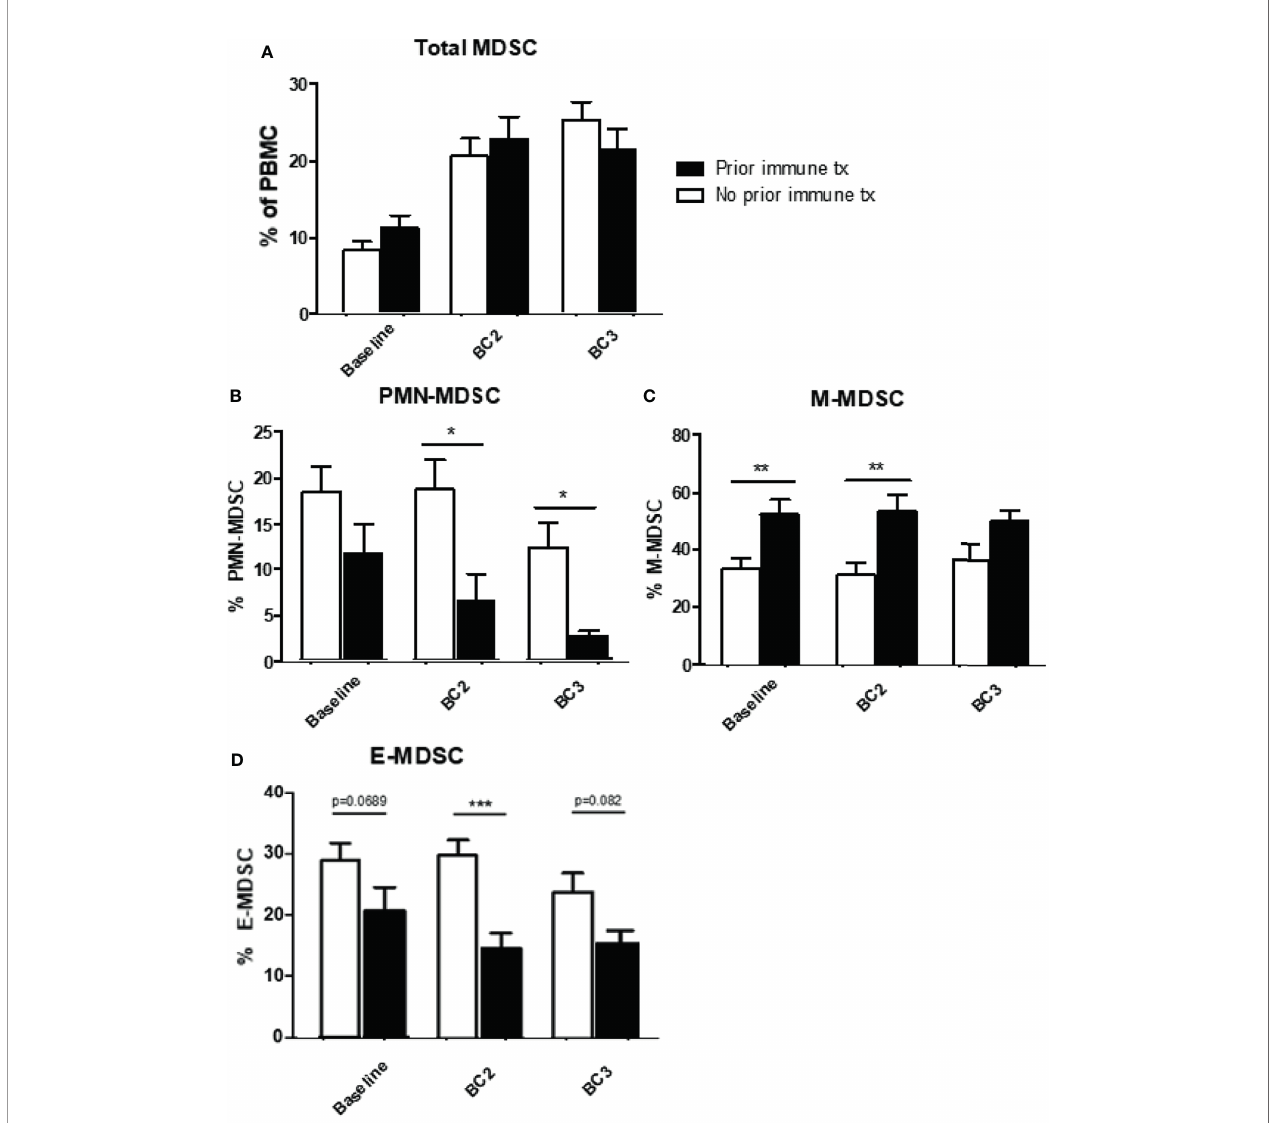
FIGURE 5 | Effects of prior immune system modulation on circulating MDSC levels. Levels of MDSC according to the receipt of prior immunotherapy. Levels of (A) total (B) granulocytic MDSC (PMN-MDSC), (C) monocytic MDSC (M-MDSC), and (D) early MDSC (E-MDSC) are shown. Data are shown as mean ± SE, *p < 0.05, **p < 0.01, ***p < ( Figure 6E ). Individual dot plots were visualized in Supplemental Figure 3 .